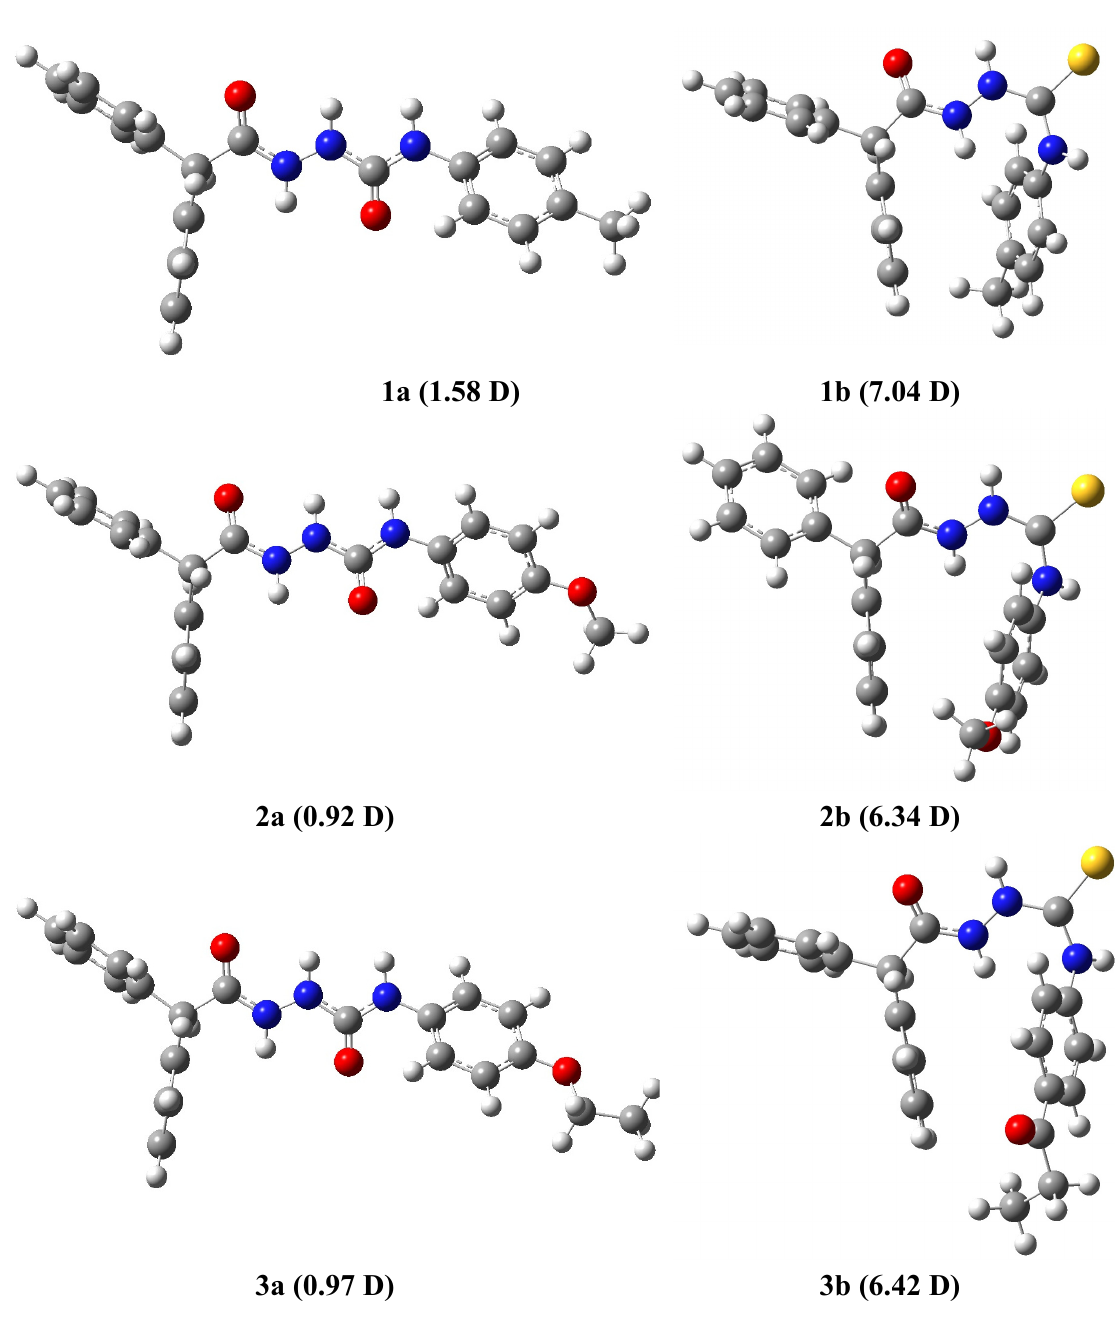
Figure 6. Molecular shapes of semicarbazides a ( left ) and thiosemicarbazides b ( right ) optimized at the molecular mechanics level with OPLS force